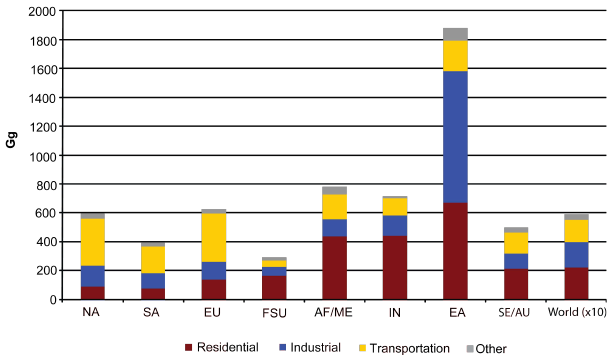
Fig. 1. Anthropogenic BC emissions by region and sector after the IPCC emissions are scaled by 1.15 to account for particles larger than 1µm in diameter. World emissions are shown divided by 10 to fit on the scale.